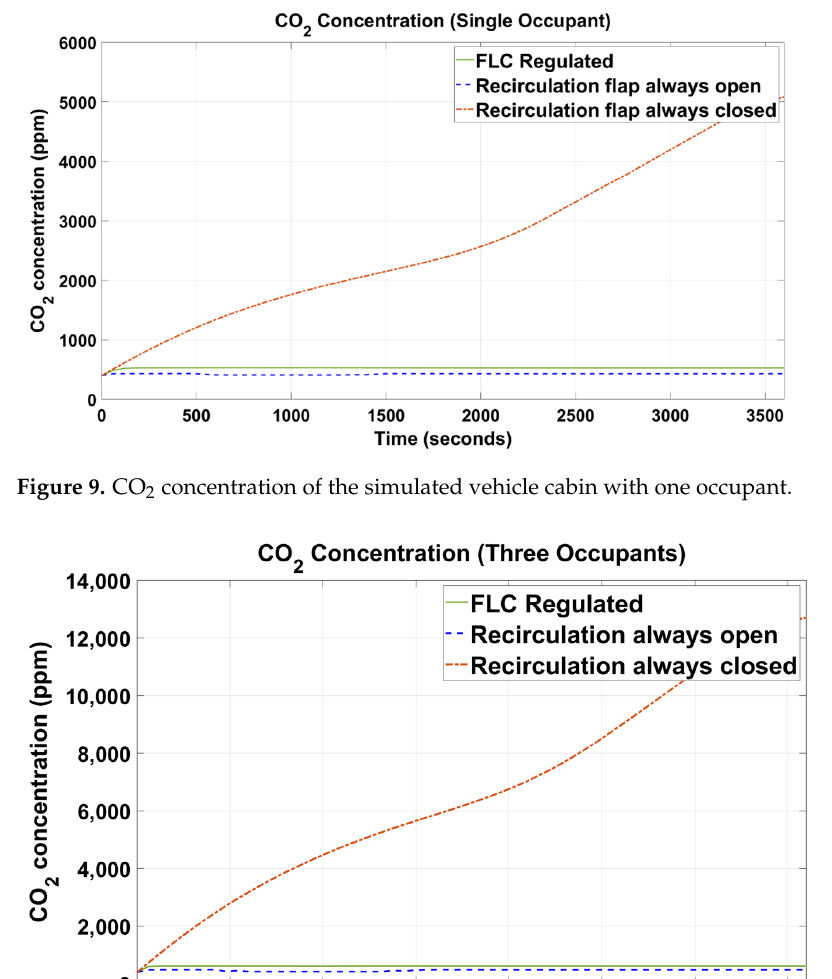
Figure 9. CO 2 concentration of the simulated vehicle cabin with one occupant.